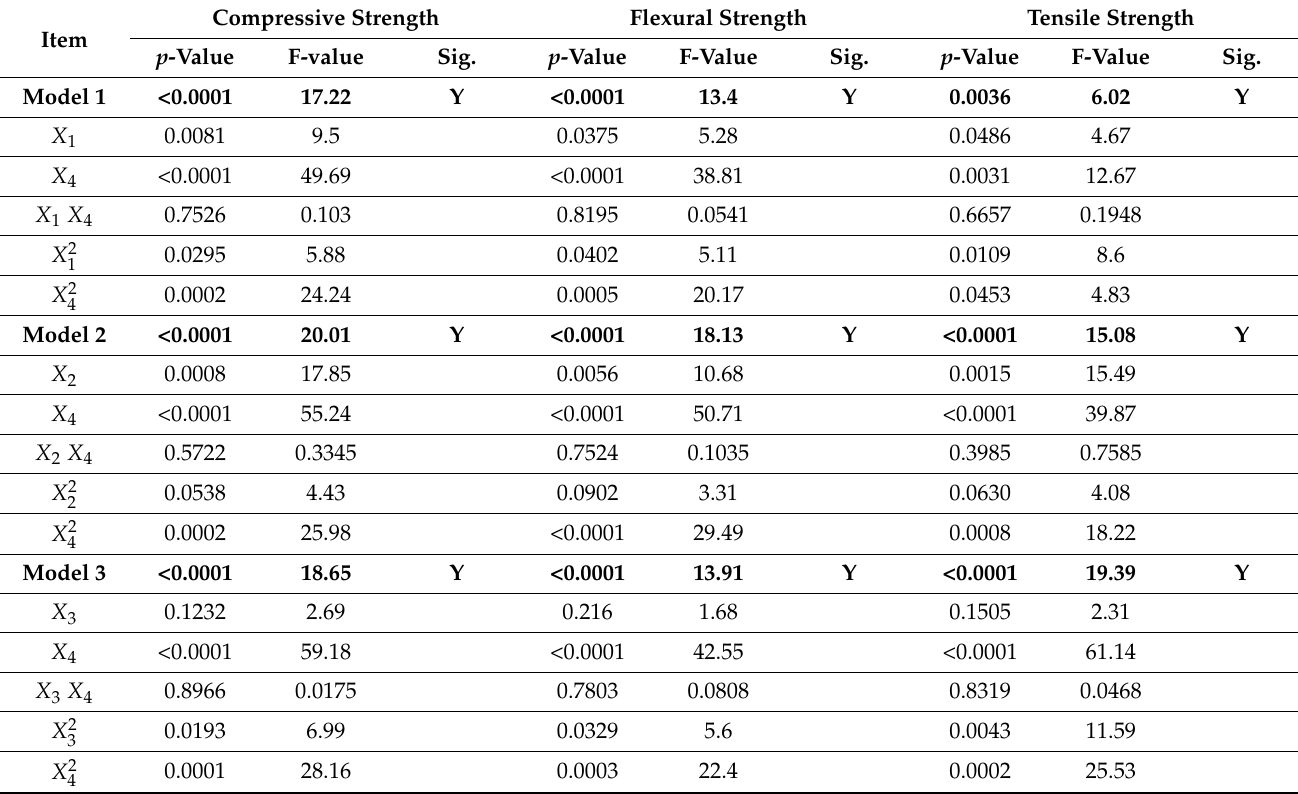
Table 4. ANOVA results for the proposed